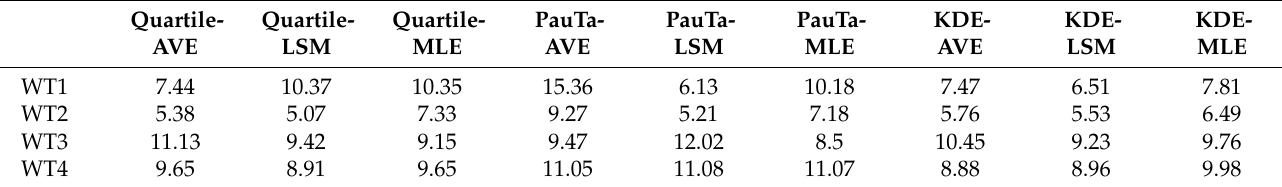
Figure 15. Rotational speed-power curve of four wind turbines. ( a ) rotational speed–power curve of WT1; ( b ) rotational speed–power curve of WT2; ( c ) rotational speed–power curve of WT3; ( d ) rotational speed–power curve of WT4. Table 5. Evaluating index s based on ECC